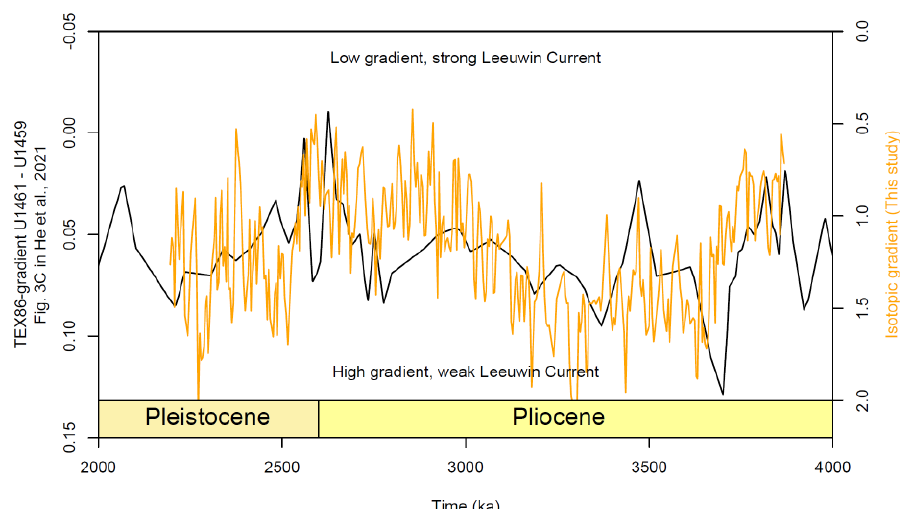
Figure D1. Comparison of the TEX86 gradient between sites U1461 and U1459 (as in Fig. 3c in He et al., 2021), and the isotopic gradient from this study. Both proxies are completely independent of each other, yet show similar patterns throughout the Plio-Pleistocene, corrobo- rating the assumption that TEX86 and isotopic gradients along the Leeuwin Current pathway are temperature driven and thus can serve as a proxy for Leeuwin Current